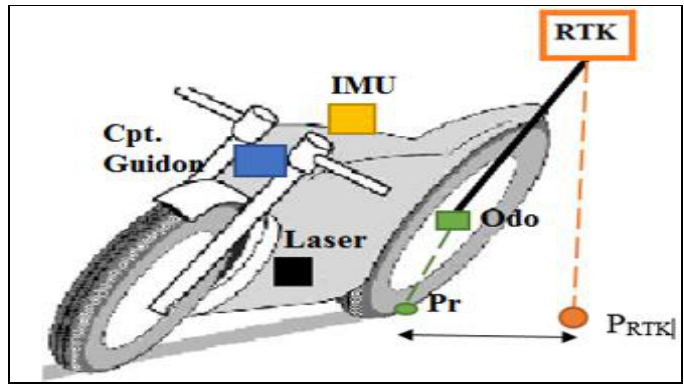
Figure 4. Sensor positioning.